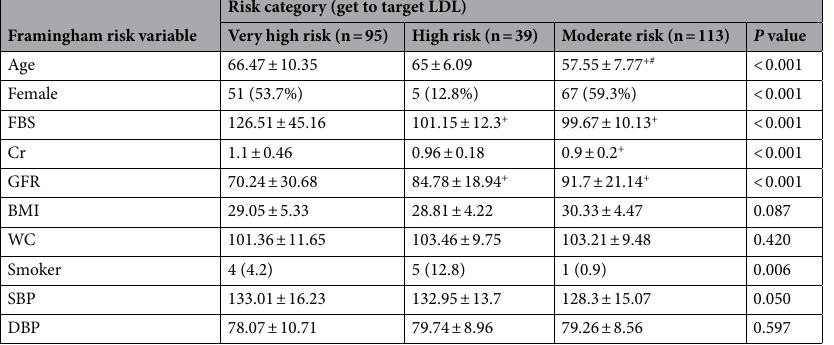
Framingham risk